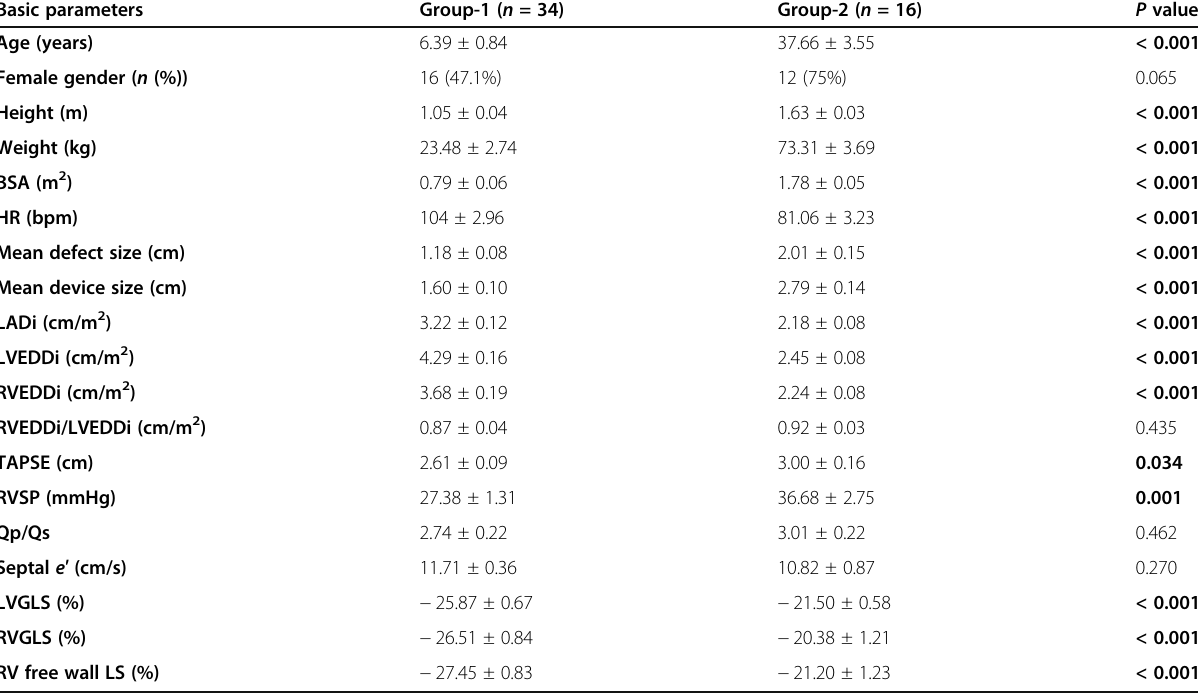
Table 5 Demographic data and baseline 2D-TTE parameters of the 2 ASD subgroups